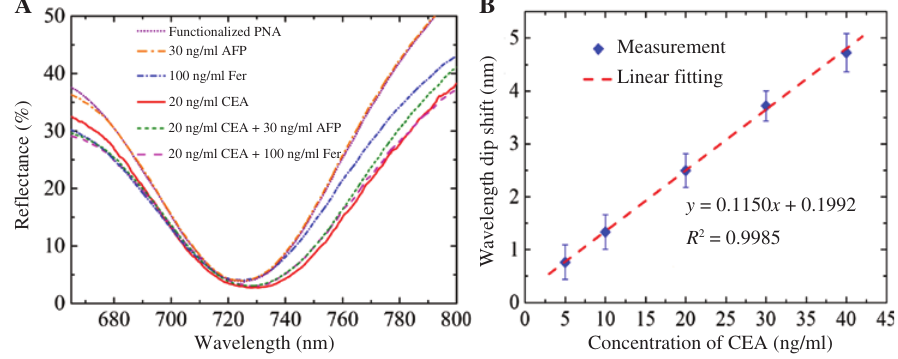
Figure 5: Immunologic specificity and sensing capability. (A) Reflectance spectra of specific tests. (B) Resonant wavelength dip shift as a function of CEA concentration. The fitting line is based on measurements from 5 to 40 ng/ml, and the error bars are based on s.d. calculation for three data points measured at each concentration. The linear fitting function y and correlation coefficient R are denoted in the